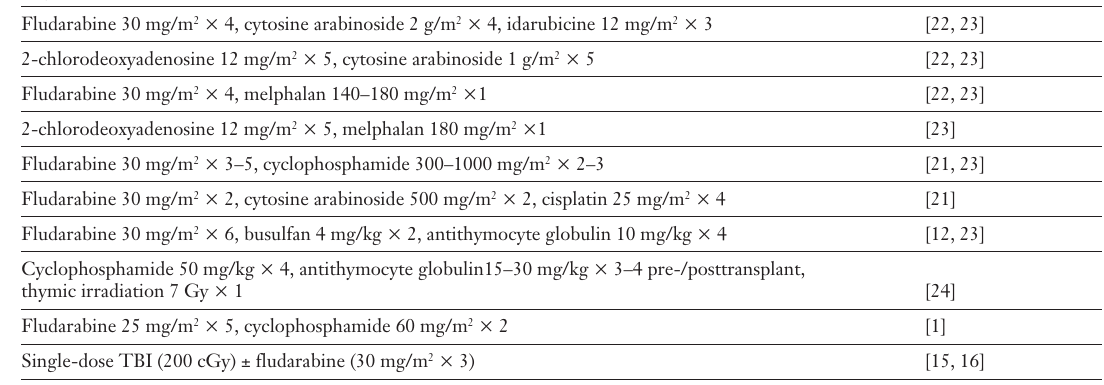
Reduced intensity conditioning